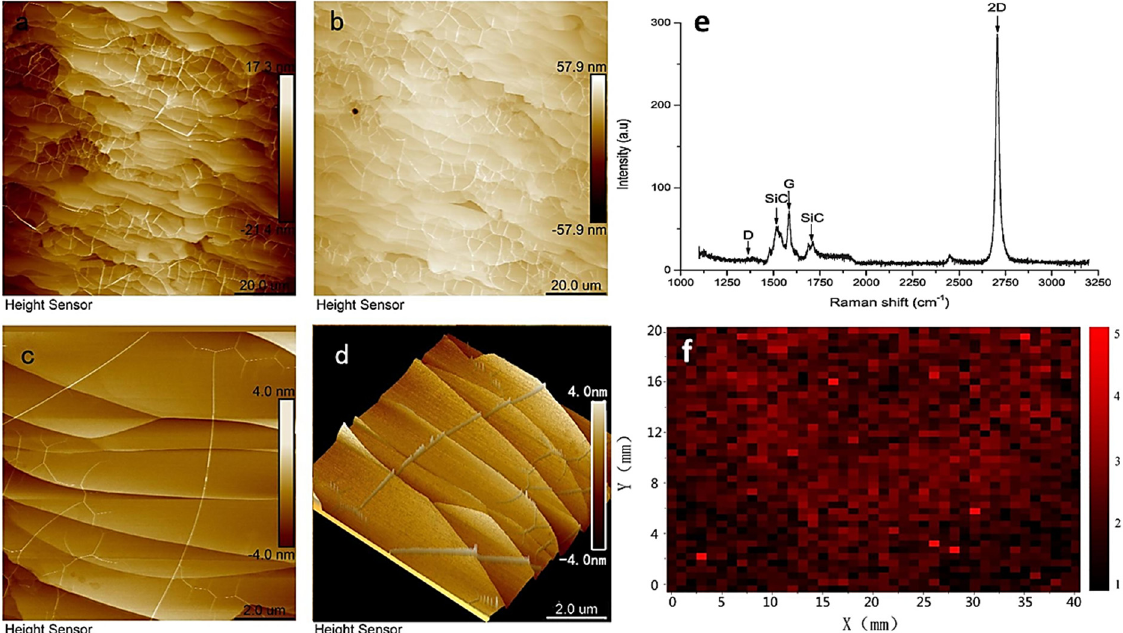
Figure 13. Topography of graphene layers using Atomic force microscope ( a , b ) in 100 × 100 µm 2 random area. ( c ) AFM image of larger size (10 × 10 µm 2 ) of a 4H-SiC graphene film. ( d ) 3D profile of epitaxial graphene in 10 × 10 µm. ( e ) Raman profile of graphene on SiC (0 0 0 1 ̅ ) substrate. ( f ) Raman mapping of graphene (I 2D /I G ). Adopted with permission from [95].